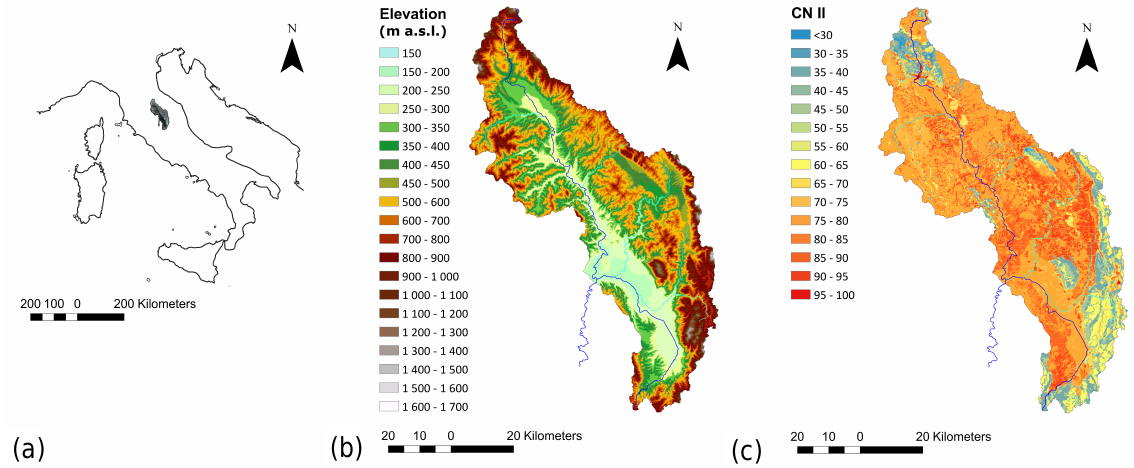
Figure 2. Maps showing (a) the location of the Upper Tiber river basin within the Italian Peninsula, (b) DEM of the watershed and (c) fine- scale land classification according to the CN II